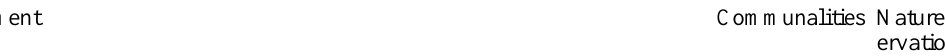
Table 2 . Spearman correlation coefficients between statements using classification of opinions about nature conservation and tourism development based on the 17 statements ( n = 246–264). Statements marked in boldface print were used to create factor variables (>